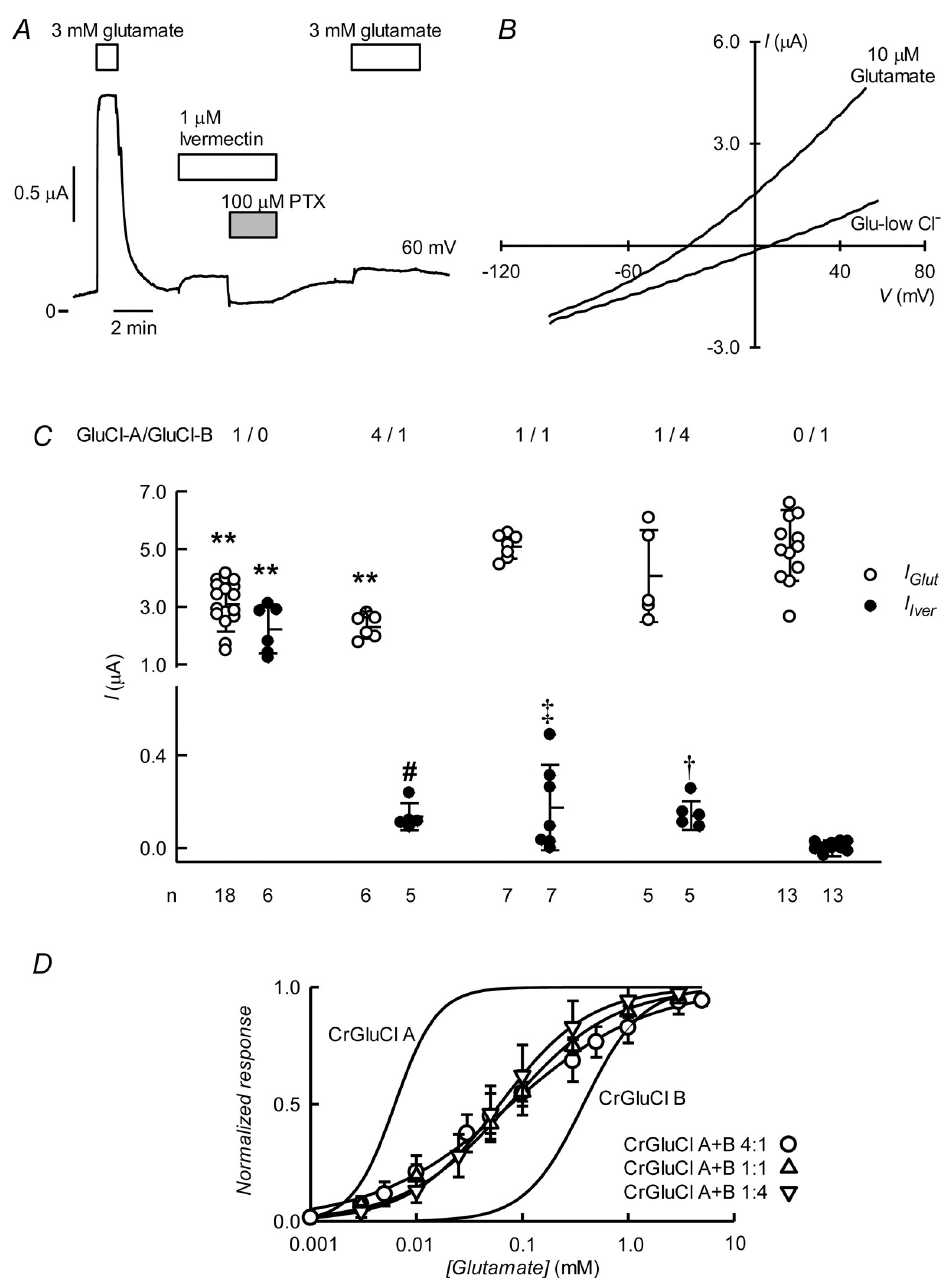
Fig 8. Functional properties of coexpressed CrGluCl-A and CrGluCl-B subunits in Xenopus oocytes. A. Currents elicited by 3 mM glutamate or 1 μ M ivermectin in an oocyte expressing subunits A and B after microinjection of 16 ng cRNA of CrGluCl-A and 4 ng cRNA of CrGluCl-B. Recording taken at 60 mV. B. IV relations corresponding to control before any addition or during the glutamate (first addition) or ivermectin challenges. C. Summary of currents elicited by glutamate or ivermectin in oocytes expressing CrGluCl-A or CrGluCl-B subunits on their own or at the various proportions indicated. Total cRNA injected was always 20 ng. Data points report individual measurements with means ± SDs also shown, n indicated under the abscissa. Glutamate or ivermectin responses significantly different from those with CrGluCl-B alone ( �� P < 0.001) as analysed by ANOVA with Bonferroni correction. The same test gave no significance for the differences in ivermectin response between any of the CrGluCl-A:CrGluCl-B mixed expressions experiments and that for CrGluCl-B alone. One sample t-test results to assess a significant difference from zero were # = 0.003, ‡ = 0.023 and † = 0.004. D. Dose-response relationship of the glutamate-sensitive currents of CrGluCl-A: CrGluCl-B mixed expression experiments. Data are normalized (means ± SD, n = 7, 7 and 5 for the 4:1, 1:1, and 1:4 mixtures respectively) to the maximal effect of. Lines are Hill equation fits. Those for the subunits expressed separately are taken from Fig 3 and shown for comparison.